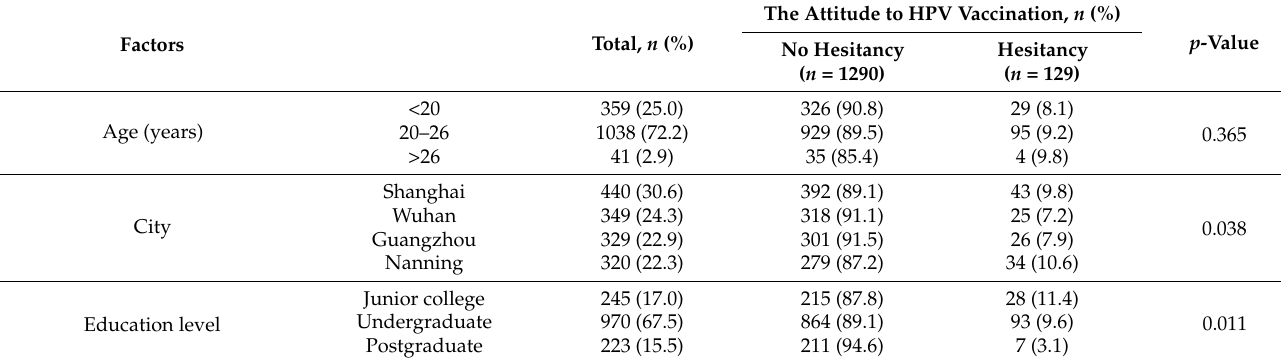
Table 2. Characteristics and HPV knowledge of university students by hesitancy